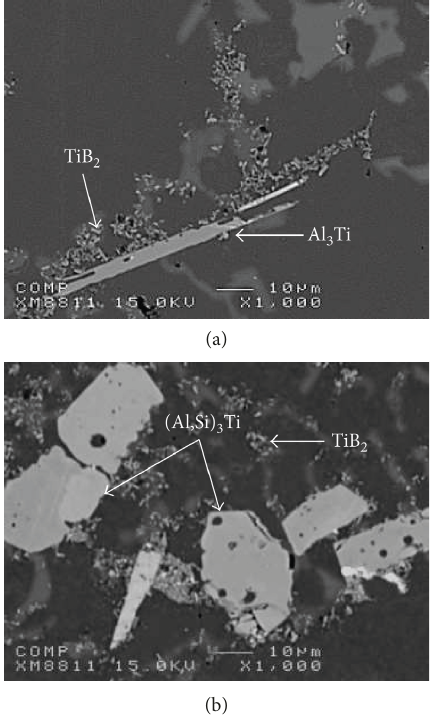
Figure 8: Decomposition of Al-5%Ti-1%B master alloy poured at 750 ° C after 60 minutes stirring: (a) 0.1%Ti and (b) 0.4%Ti.